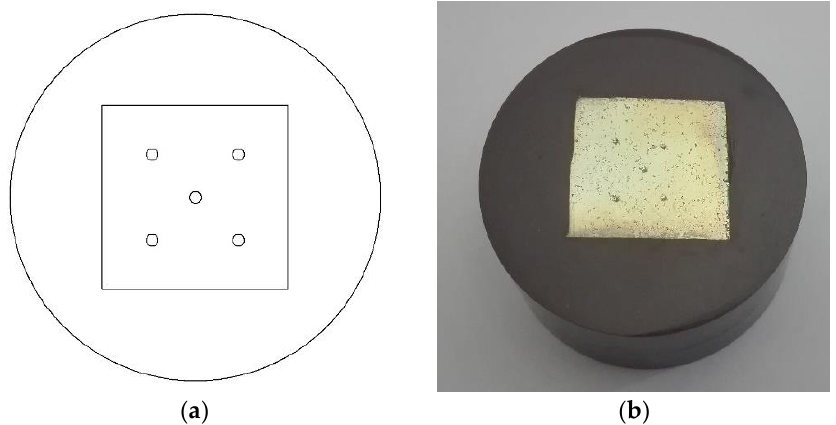
Figure 4. The sample prepared for hardness testing: scheme of the specimen ( a ) and real sample ( b ).